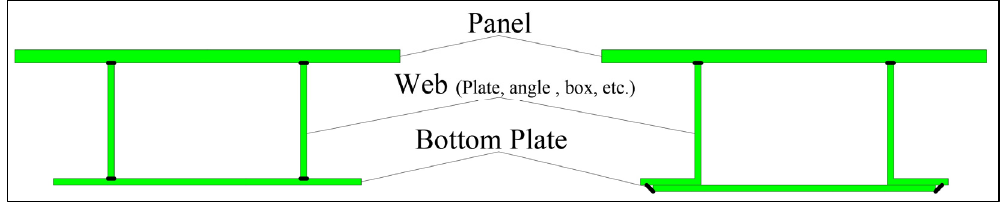
Figure 4. Orthotropic built-up closed-rib section concept.